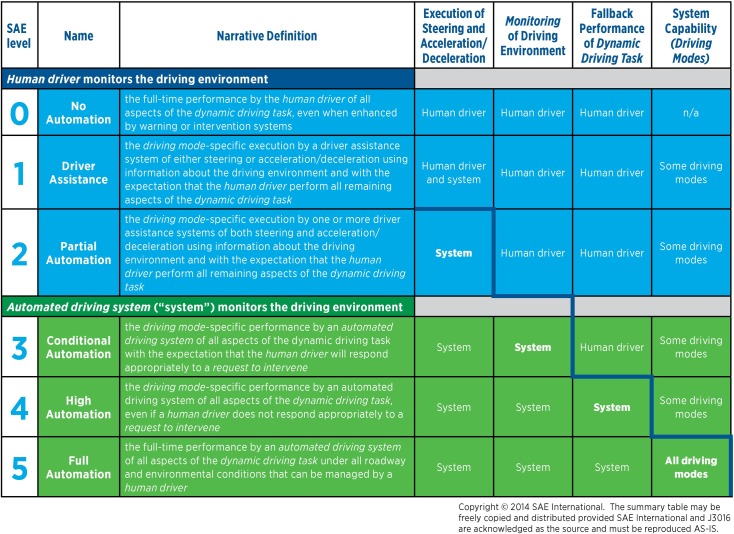
AV levels of automation.Reproduced AS-IS with permission from SAE-International J3016TM, [5].